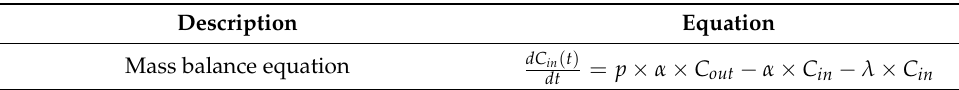
Table 8. Mass balance equation.